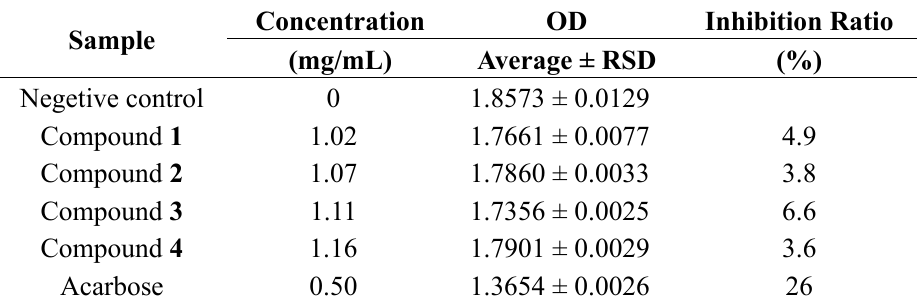
Table 5. The inhibitory activity of the compounds 1 – 4